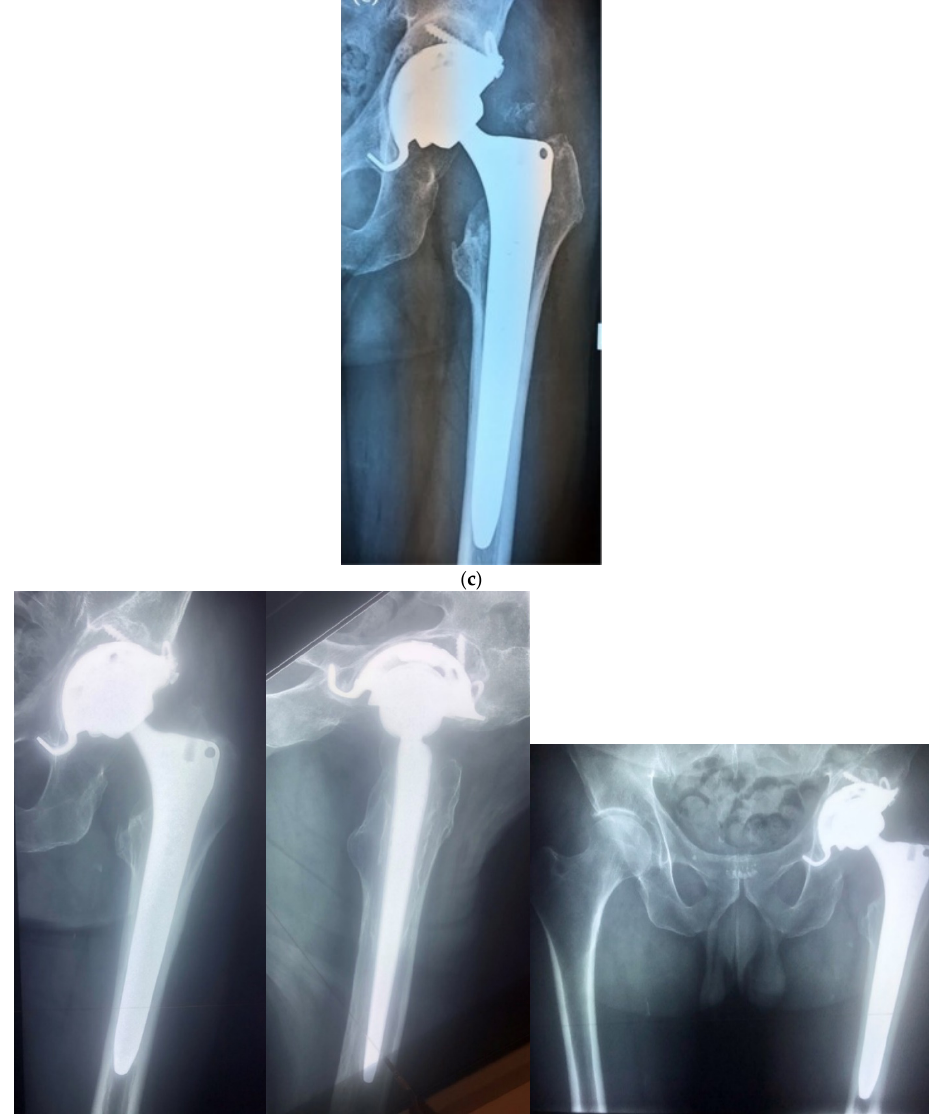
Figure 4. Radiographs of a 66-year-old male who sustained a femoral neck fracture treated with uncemented total hip arthroplasty. Postoperatively, he complained of unspecific pain with only slightly elevated infection markers. ( a ) Three years later, loosening of the acetabular component was diagnosed with marked osseous defect periacetabular and signs of osteolysis around the proximal part of the stem. ( b ) One-stage exchange with uncemented components. The defects were filled with antibiotic-impregnated bone (OSTEOmycin TM V). Sonication of explanted material revealed growth of two strains of methicillin-resistant S. epidermidis and Propionibacterium sp. The hospital stay was one week, with cefuroxime intravenously, followed by six weeks of amoxicillin/clavulanic acid and rifampicin orally. ( c ) Six months postoperatively, the patient is pain-free with no sign of infection and unlimited mobility. There is partial remodeling of the allograft. Figures taken from previous publication in EOR Winkler (2017) [67]. ( d ) 6,5 years postoperatively. Unlimited weight-bearing,